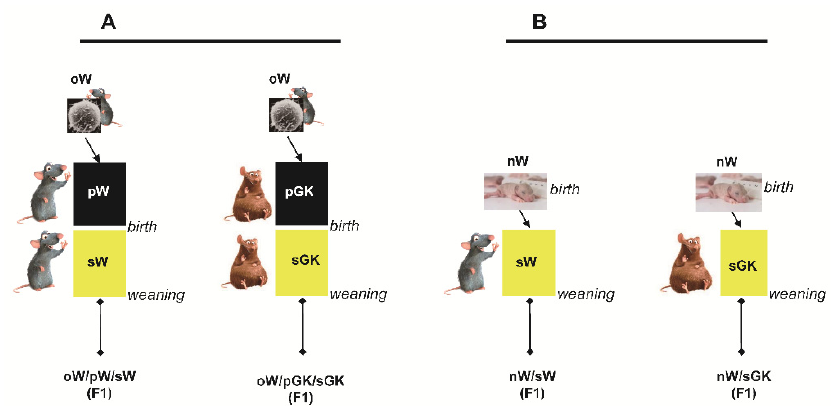
Figure 1. Flow chart illustrating the F1 rat groups reared under control (oW/pW/sW and nW/sW) and exposure to maternal diabetes (oW/pGK/sGK and nW/sGK) conditions. ( A ): Adult animals were obtained from Wistar (W) ovocytes (oW), transferred into W mothers (pW) and reared with W dams (oW/pW/sW group) or obtained from oW ovocytes, transferred into GK mothers and reared with GK dams (oW/pGK/sGK group). ( B ): Adult animals were issued from W neonates and suckled by GK foster mothers (nW/sGK group) or W foster mothers (nW/sW group). oW: Wistar ovocyte; pGK: pregnant GK mother; pW: pregnant W mother; sGK: suckling GK mother; sW: suckling W mother.